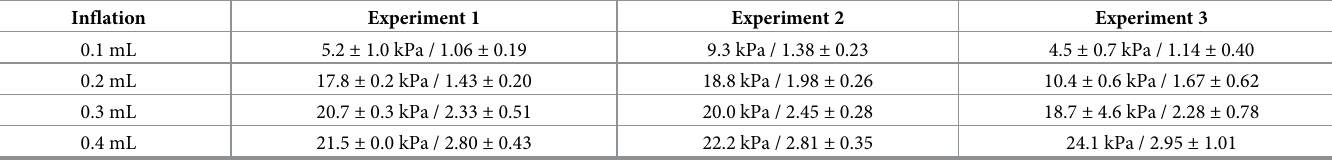
Table 4. Inflating pressure (kPa) / radial stretch (-) measured from the three replicas of the inflation